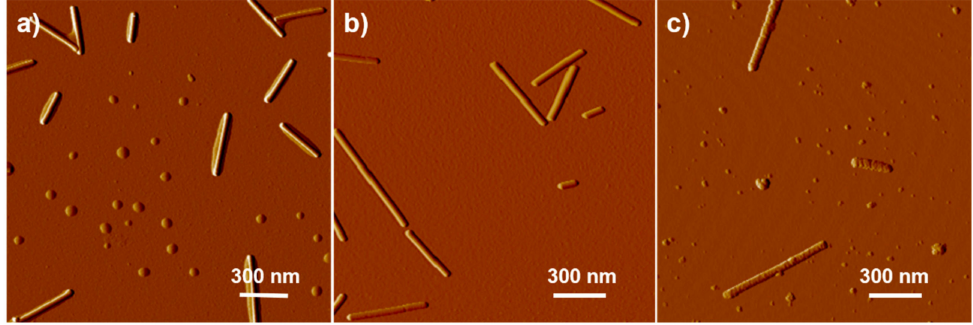
Figure 4. AFM amplitude images of TMV-Cys-PPGA: ( a ) before and ( b ) after purification. ( c ) TMV-Cys-PPGA mineralized with